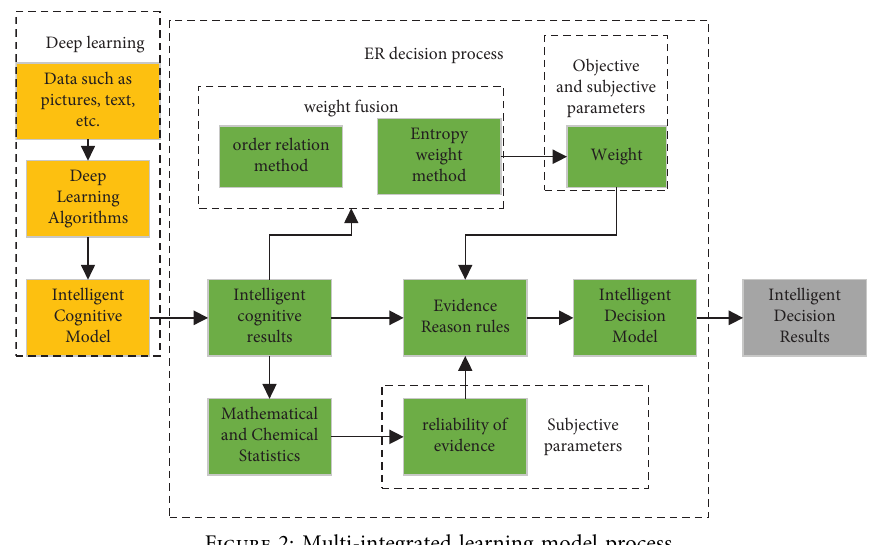
Figure 2: Multi-integrated learning model